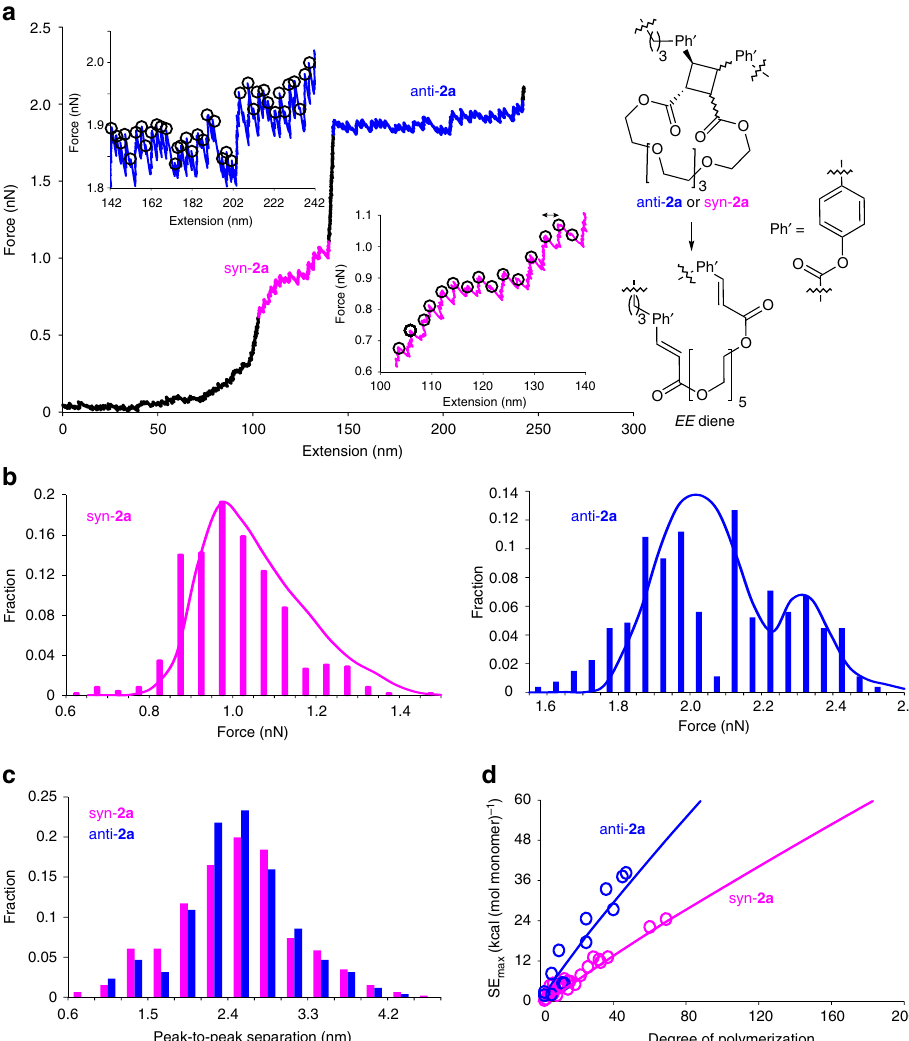
Fig. 4 Summary of single-chain mechanochemistry of macrocyclic cinnamate dimers. a A representative force/extension curve of copolymer P2 . The two plateaus, resulting from dissociations of syn- 2a and anti- 2a to E,E diene are highlighted in magenta and blue, respectively. Magni fi ed plateau regions in the insets illustrate the saw-tooth pattern corresponding to dissociation of individual dimers, identi fi ed by black circles. b The experimental (bars) and computed (solid lines) distribution of dissociation forces at the 1st (magenta) and the 2nd (blue) plateaus. c The observed distribution of peak-to-peak separations, corresponding to an increase in the polymer contour length upon dissociation of individual dimers. d Calculated (solid lines) and experimentally derived (circles) maximum strain energies that a single macromolecule of syn- 2a (magenta) or anti- 2a (blue) can sustain before